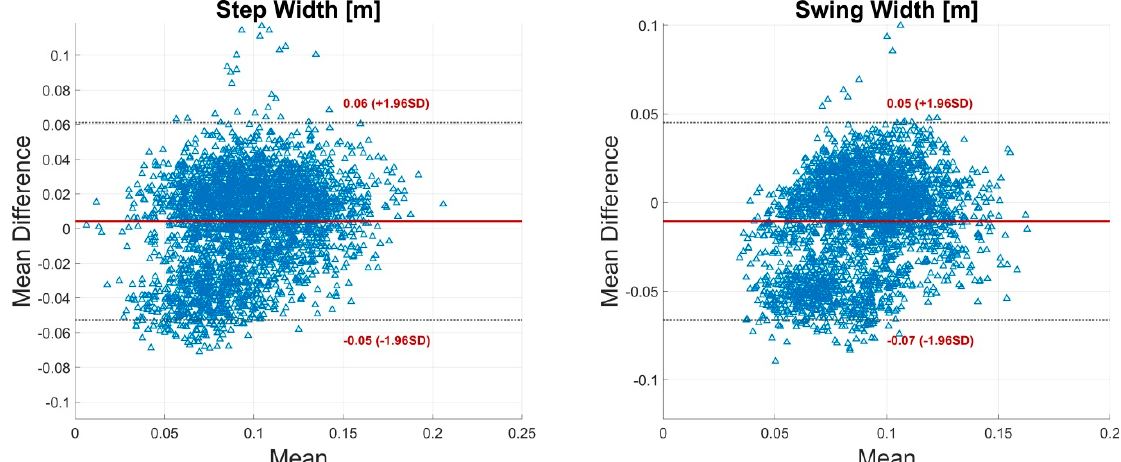
Figure 6. Bland-Altman (BA) plots for step width and swing width. Each plot contains all calculated data points of one parameter of all subjects. The solid line indicates the mean difference. The dashed lines indicate the limits of agreement (LoA) (95% CI of the mean difference).